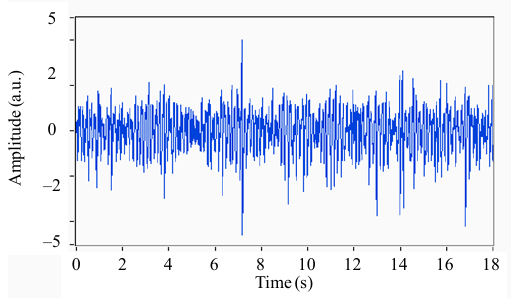
Fig. 25 Time-domain waveform of vibrations generated by the train.